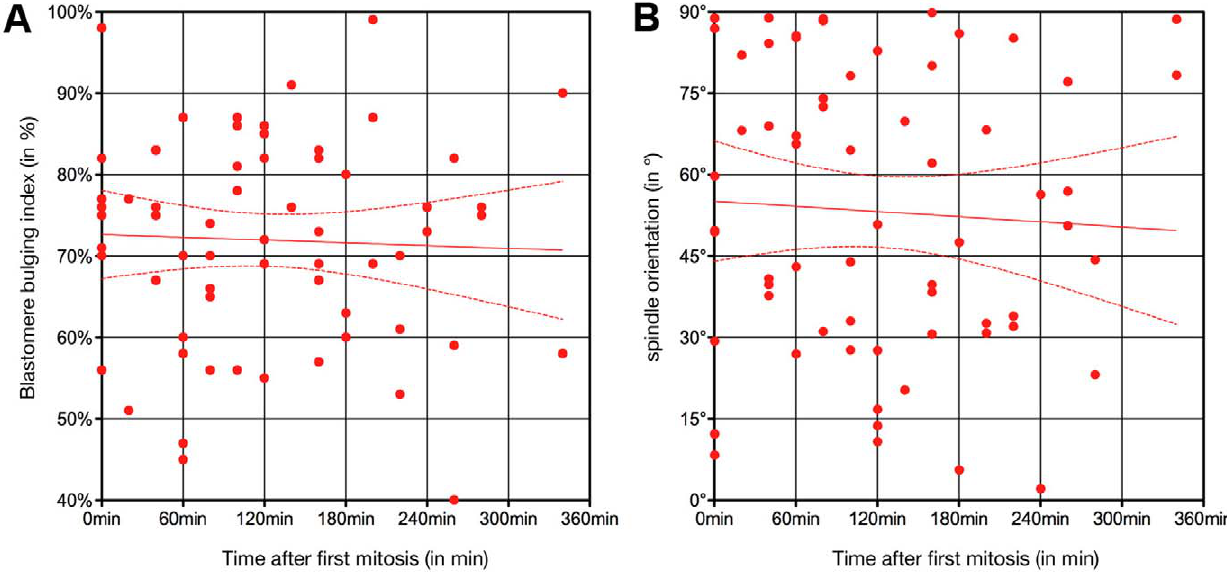
Figure 10. Spindle orientation and bulging in early dividing blastomeres. Neither blastomere bulging during mitosis (A) nor spindle orientation (B) is influenced in early dividers. Each point corresponds to a